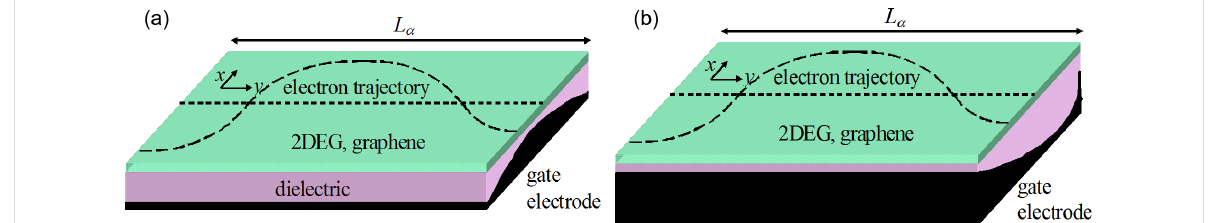
Figure 1: Schematic representation of a configuration that implements a tunable FrFT using (a) a convex, and (b) a concave gate electrode.